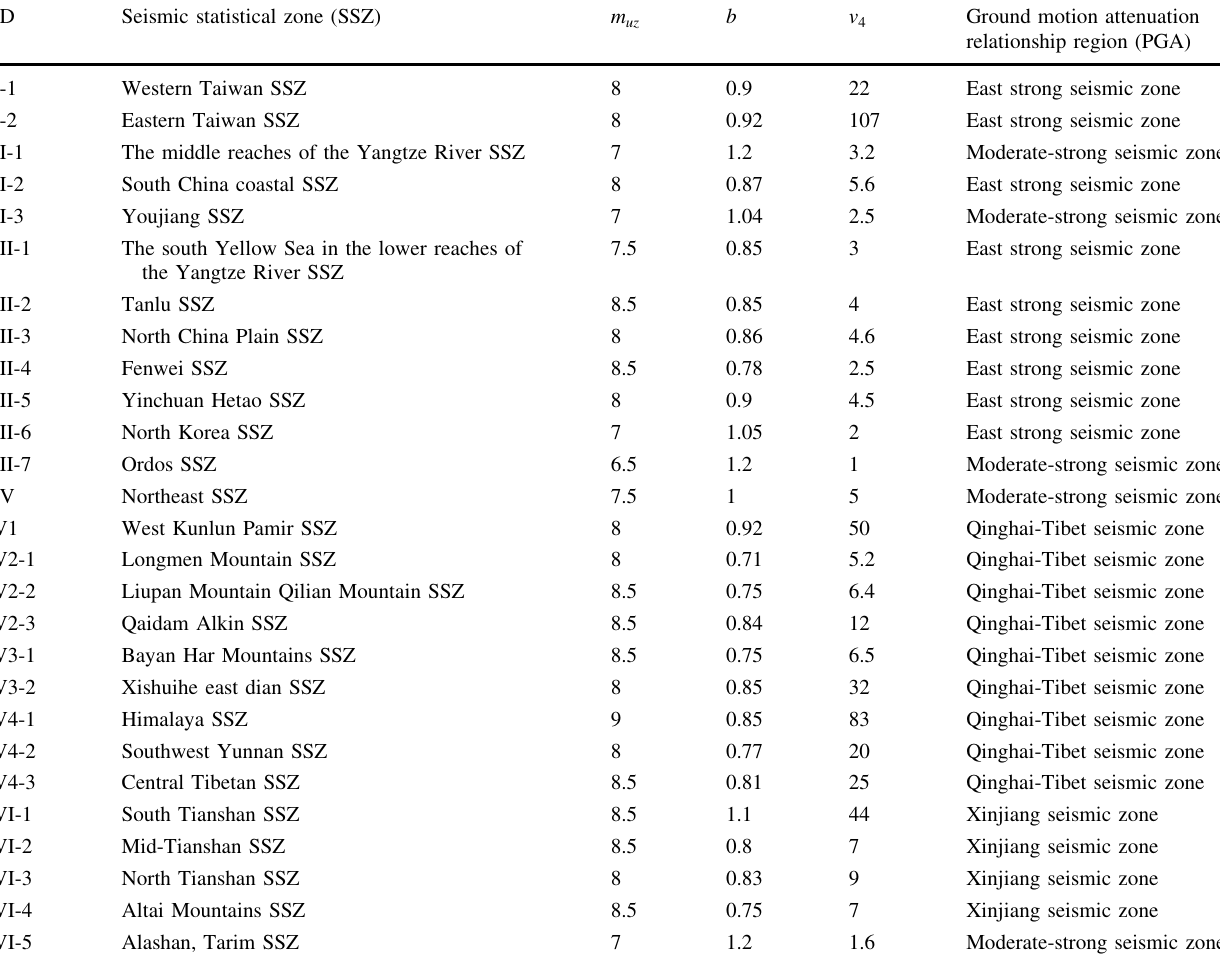
Table 1 Parameters of the seismic statistical